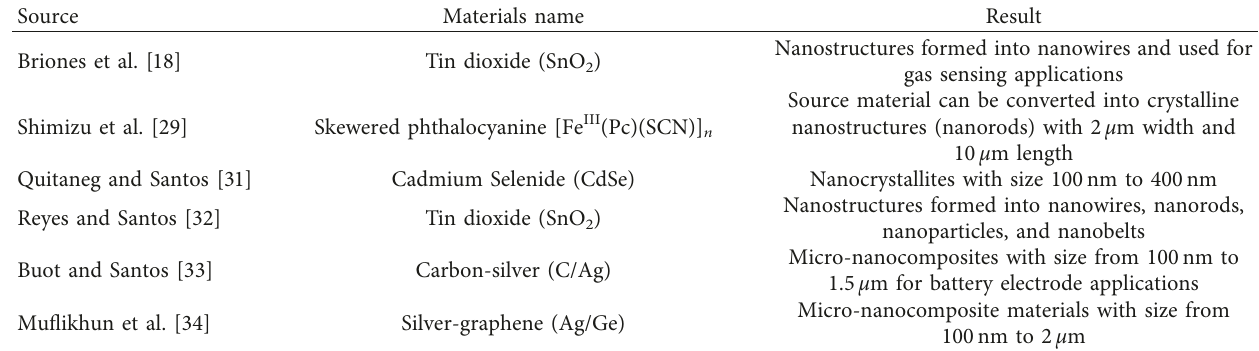
Table 2: Previous study of nanomaterials synthesized via HVPG